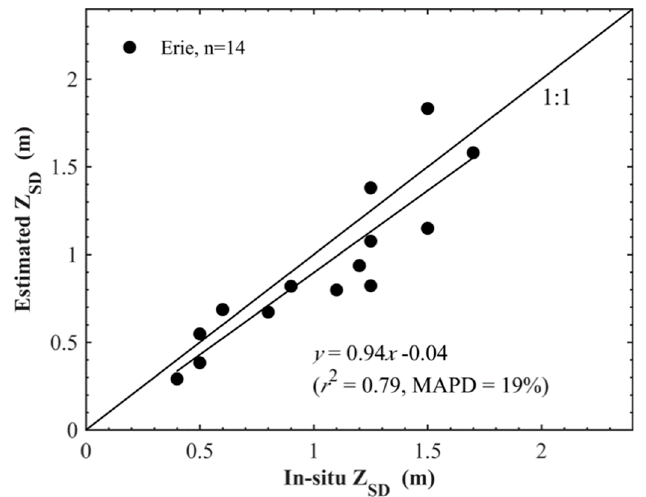
Figure 9. Comparison of estimated and in-situ Z SD with the Erie dataset.